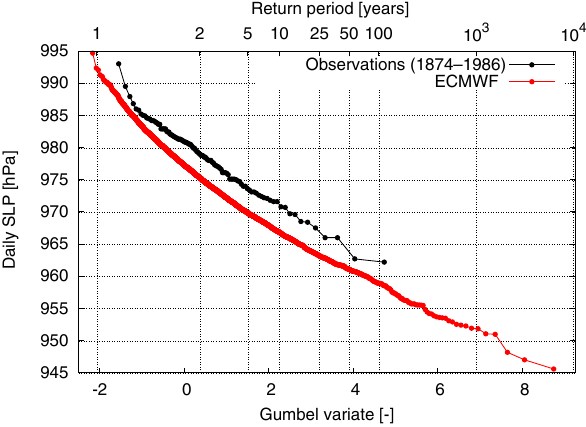
Figure 3. Gumbel plot of observed annual minimum sea level pressure (SLP) in Nordby (black) and as simulated at the nearest ECMWF grid point (red). The location of Nordby is indicated in Fig.